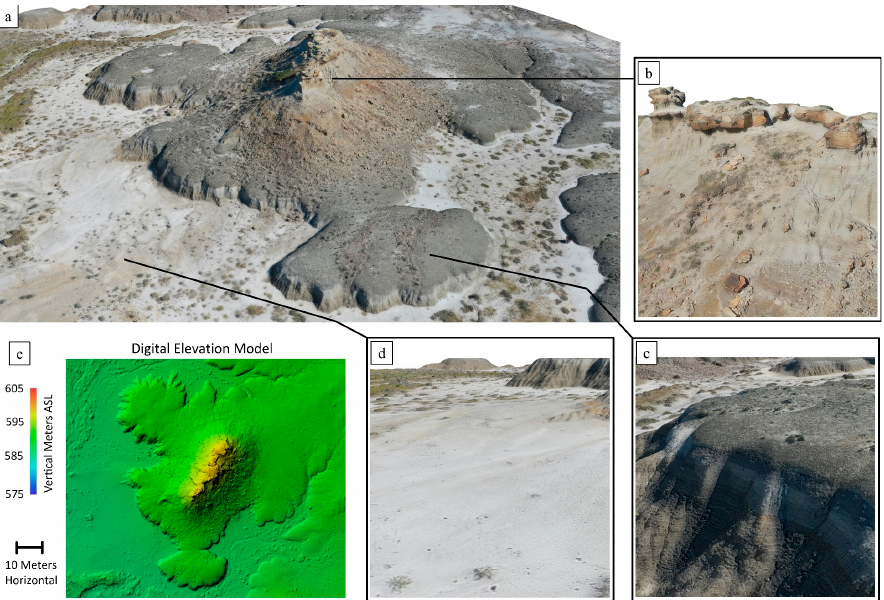
Figure 1. Survey of the investigated site: ( a ) panoramic overview; ( b ) sandstone; ( c ) mudrock; ( d ) pediment; and ( e ) digital-elevation model .